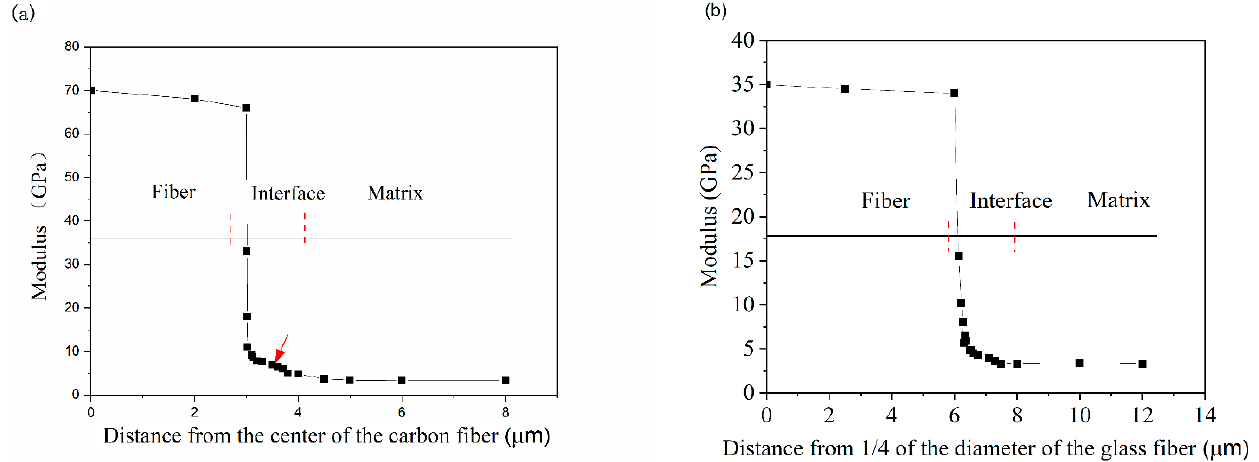
Figure 5. Interface around the carbon and glass fibers: ( a ) carbon fibers and ( b ) glass fibers.